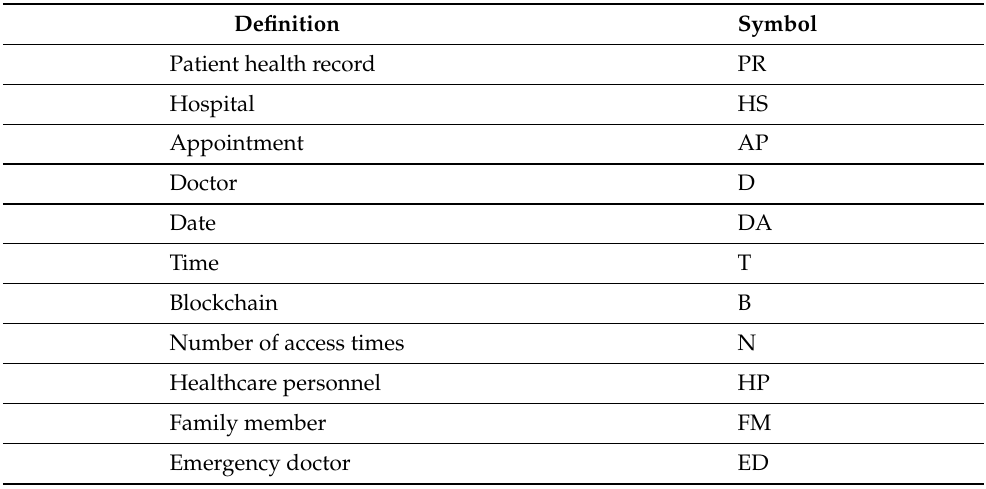
Table 5. Definitions and symbols